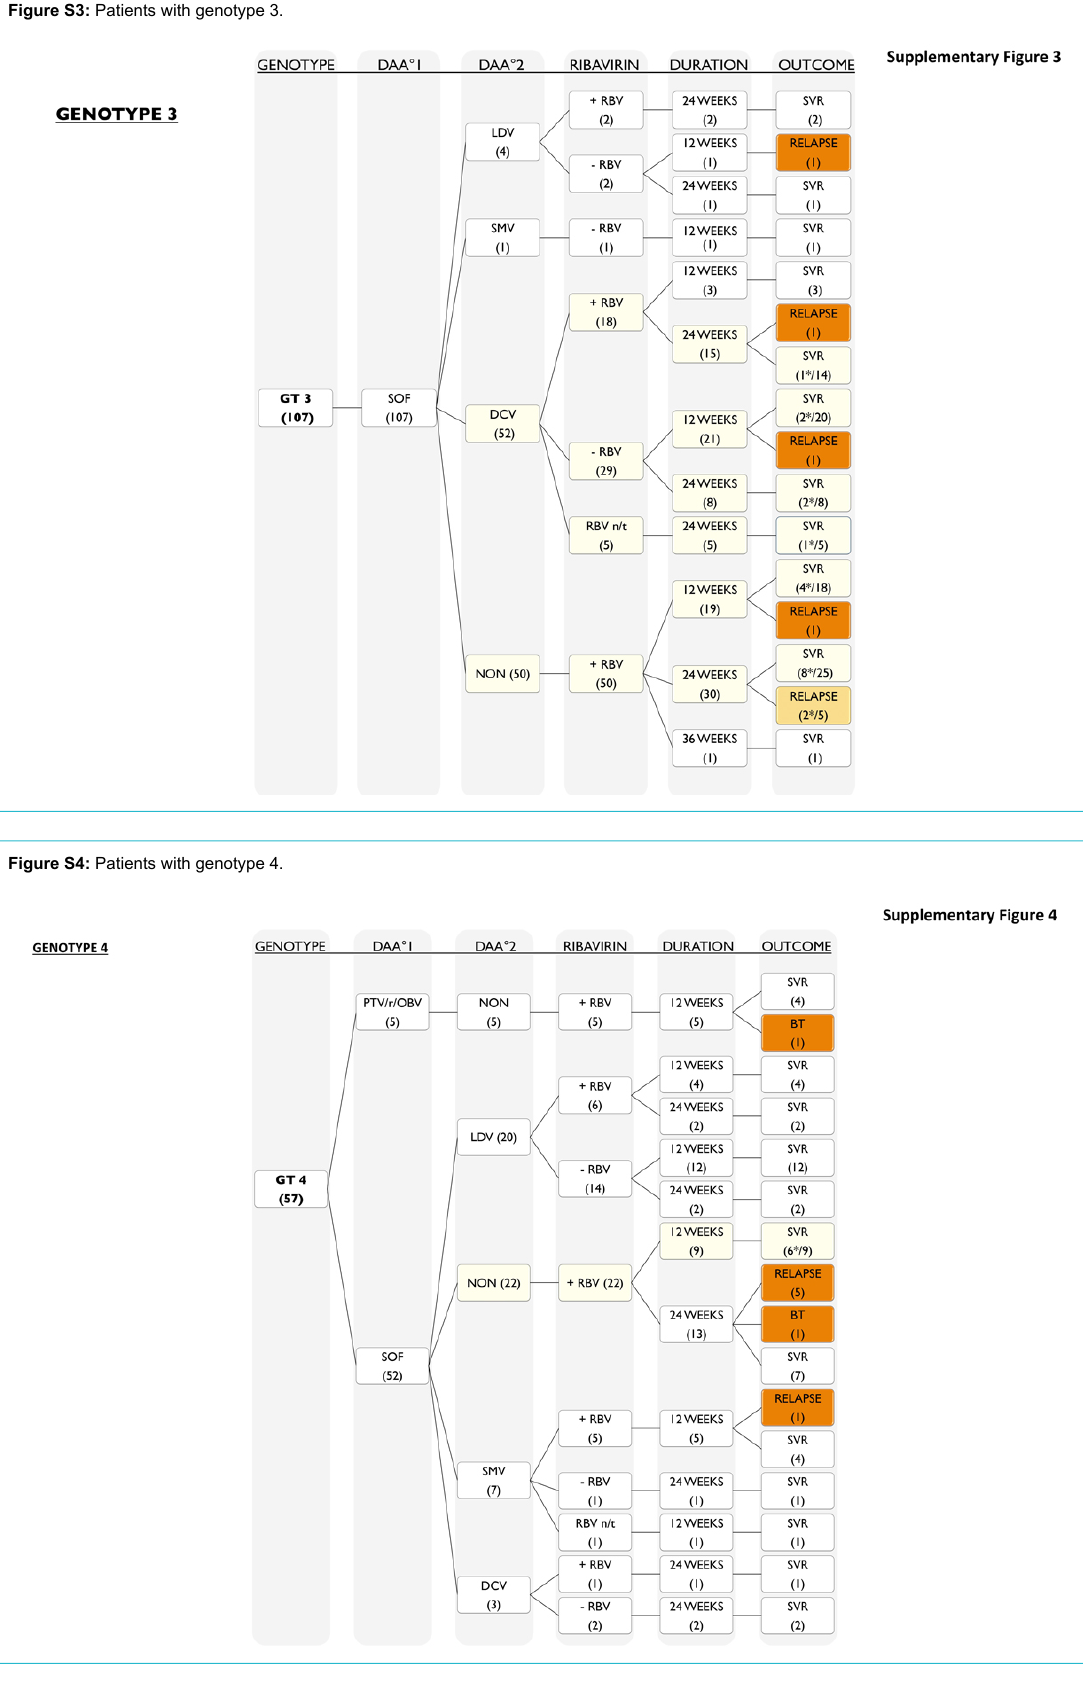
Figure S3: Patients with genotype 3.